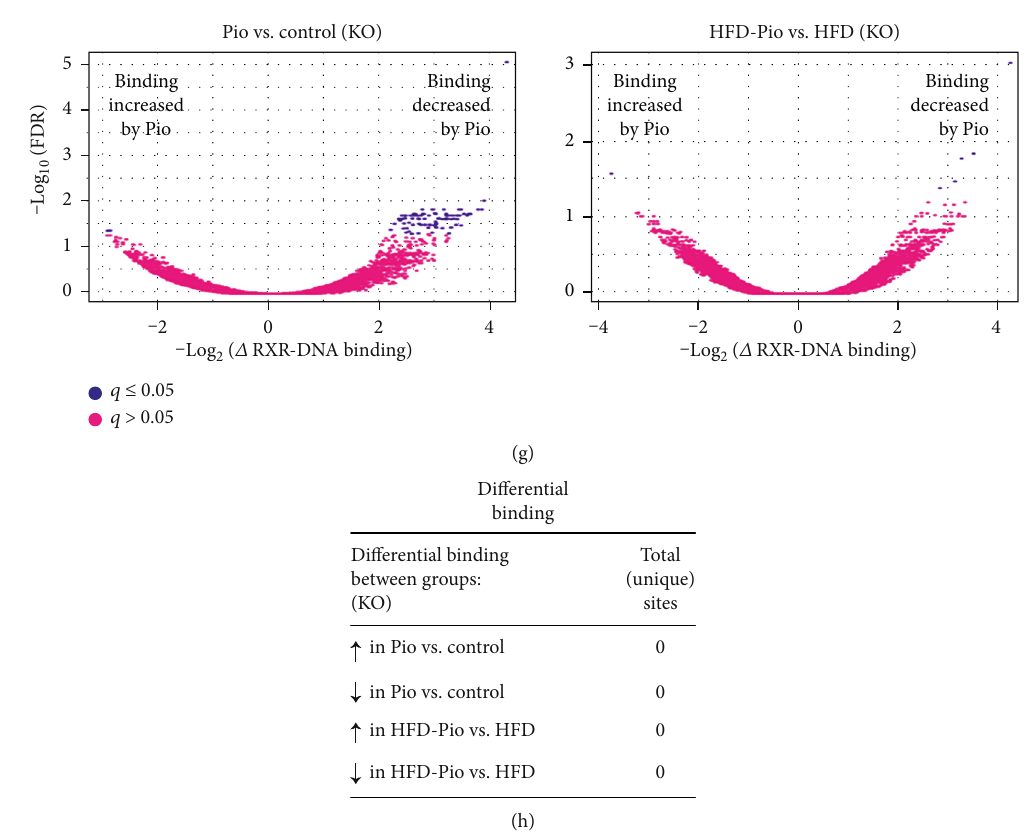
Figure 5: E ff ects of Pio on the hepatic RXR cistrome. (a) Total RXR-DNA binding sites (by group), (b) Volcano plots comparing di ff erential RXR-DNA binding in replicate livers from Pio- versus Control- or HFD-Pio- versus HFD-treated groups of mice, and (c) Total (and unique) DNA sites with signi fi cantly di ff erent RXR-DNA binding (between groups), each de fi ned as described in Experimental methods. (d) Venn diagram of overlap between sites of signi fi cant Pio-induced RXR-liver DNA binding in mice on control versus HFD. (e) Pie chart illustration of the locations of sites for genes summarized in (d) with respect to gene-speci fi c transcription start sites in control versus HFD mice. (f – h) Results of corresponding RXR-liver DNA binding ChIP-Seq analyses of liver-speci fi c PPAR γ KO